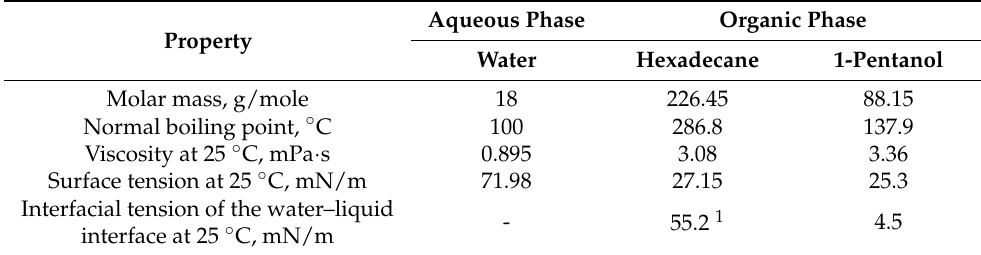
Table 1. Properties of liquids used for the membrane contactor